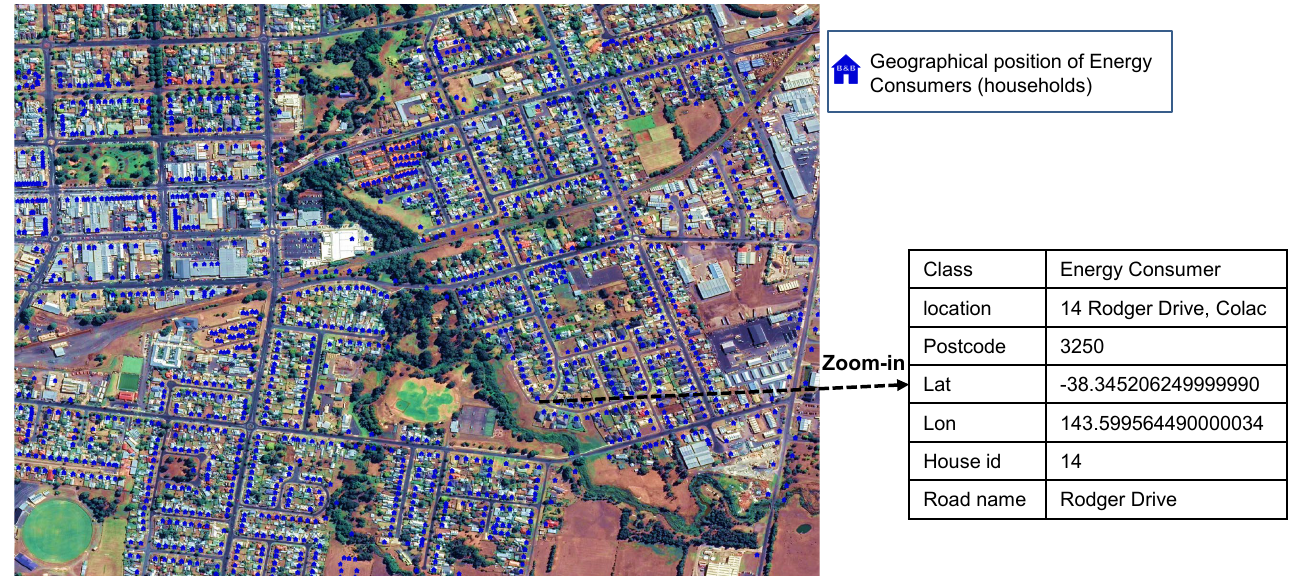
Figure 2. Satellite view of GPH algorithm showing the geographical positions of Figure : Energy consumers in COLAC, Victoria, Australia.